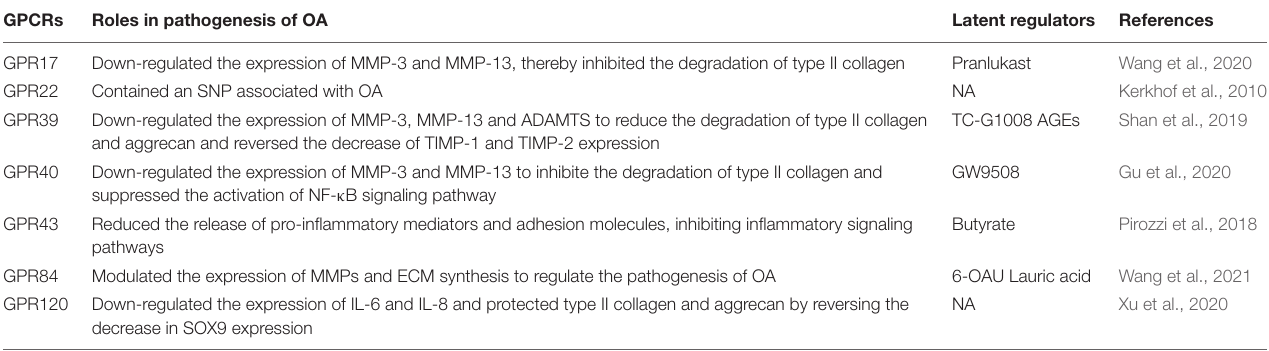
TABLE 2 | Novel roles of other 7TM receptors in